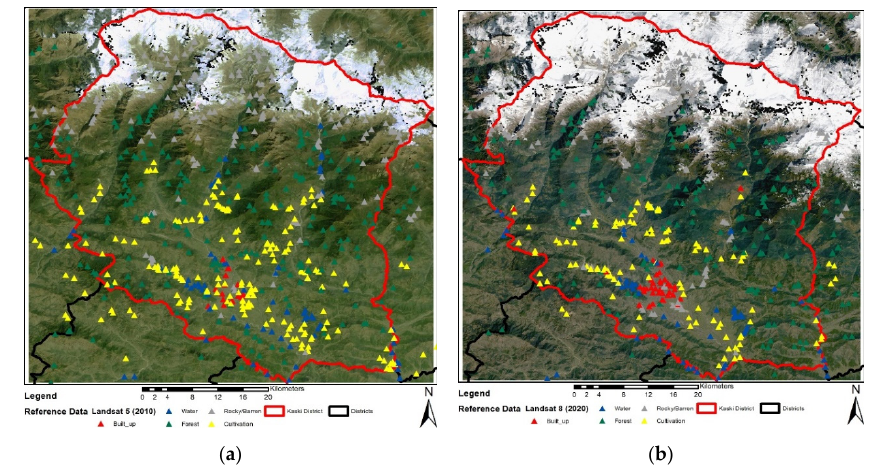
Figure 4. Distribution of training data: ( a ) for the year 2010; ( b ) for the year 2020.